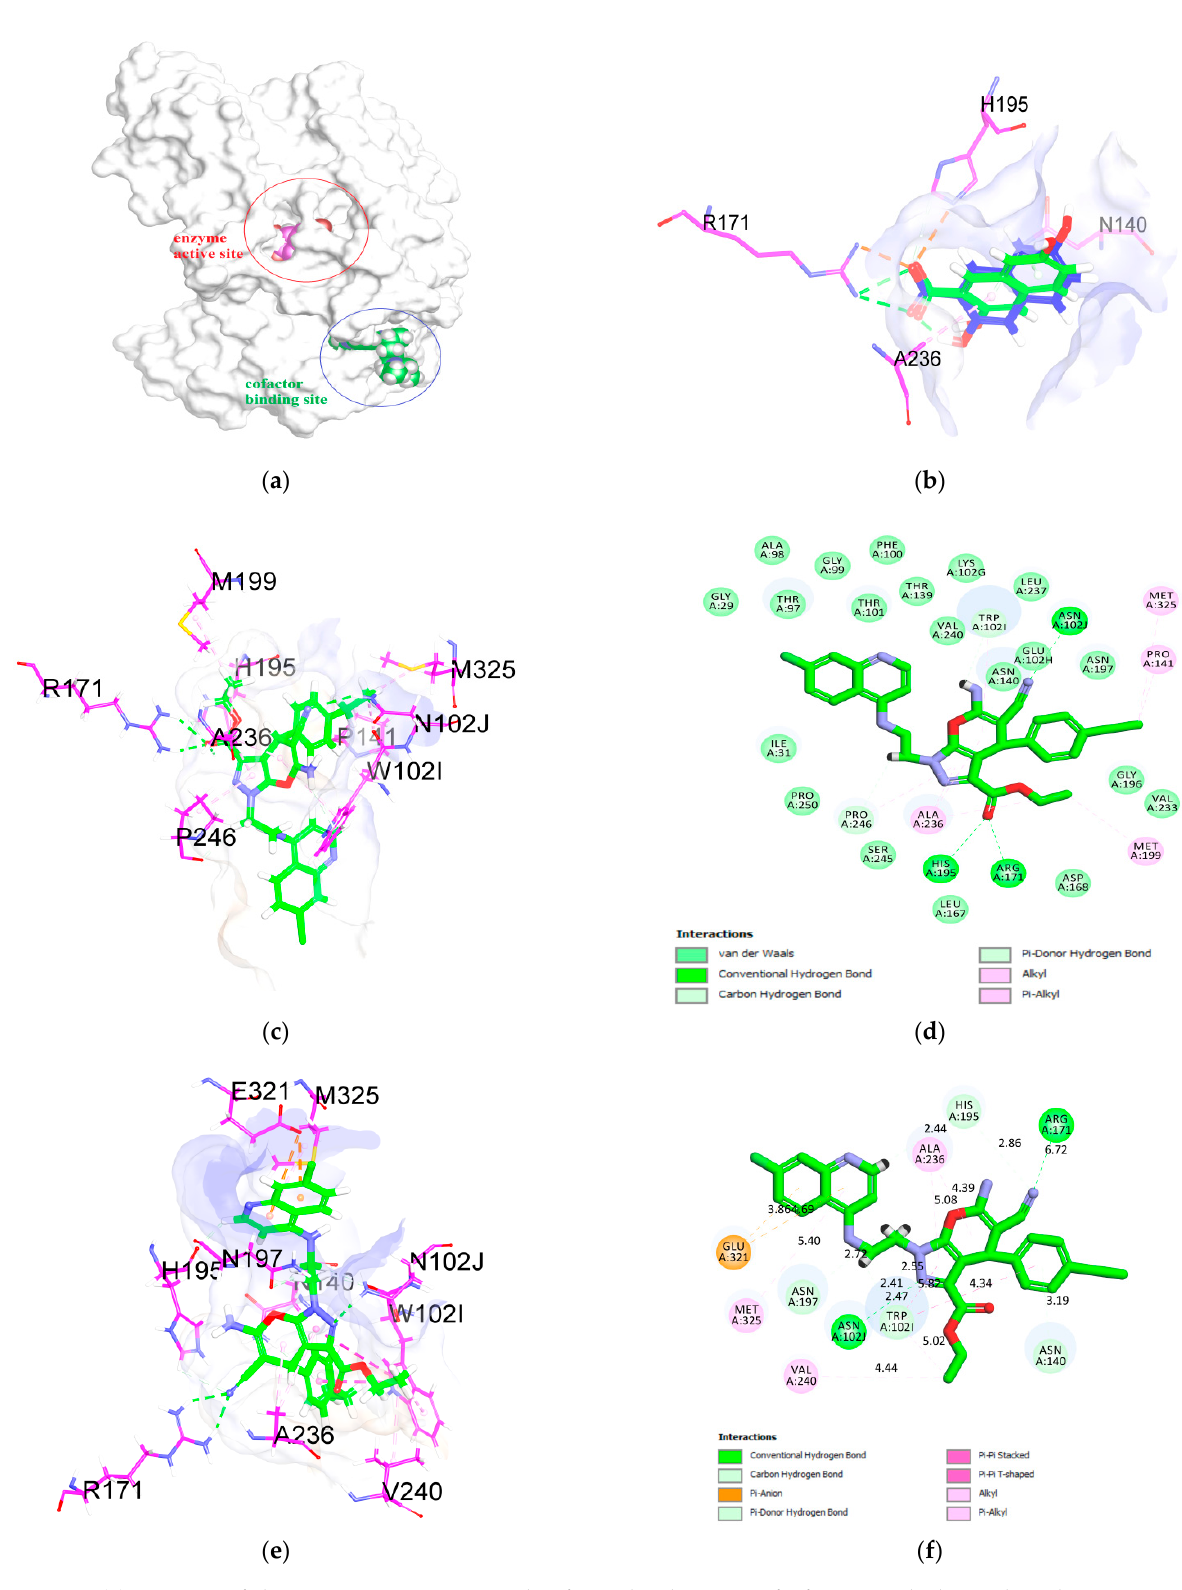
Figure 5. ( a ) Position of the enzyme active site and cofactor binding site of PfLDH. Both the pink and green space-filling calotte models represent the binding position of the co-crystallized inhibitors, 3,5-dihydroxy-2-naphthoic acid and chloroquine. ( b ) Superposition of the docked ligand with the co-crystallized ligand (blue carbon atoms) (RMSD value of 1.32 Å). Best binding pose of compound 4b in the first ( c ) and second ( e ) cluster results. ( c ) 2D-docking pose of compound 4b in the first ( d ) and second ( f ) cluster